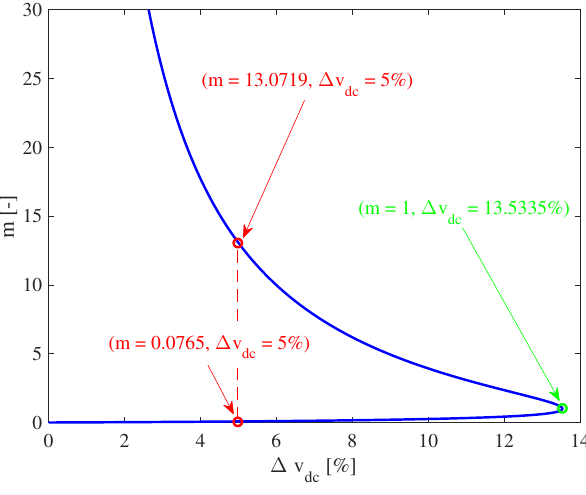
Figure 9. Values of m to provide a desired ∆ v dc